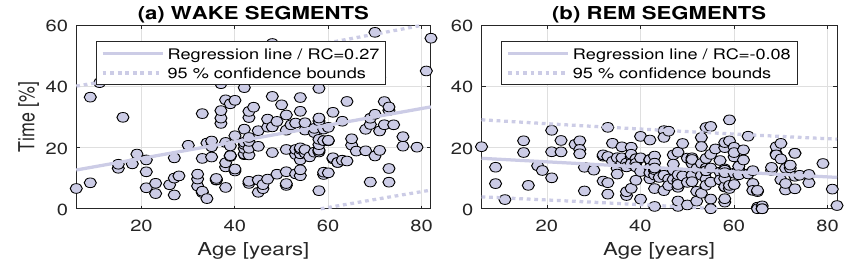
Figure 5. The distributions of the lengths of the Wake and REM sleep stages related to age for the whole set of 184 individuals under study.